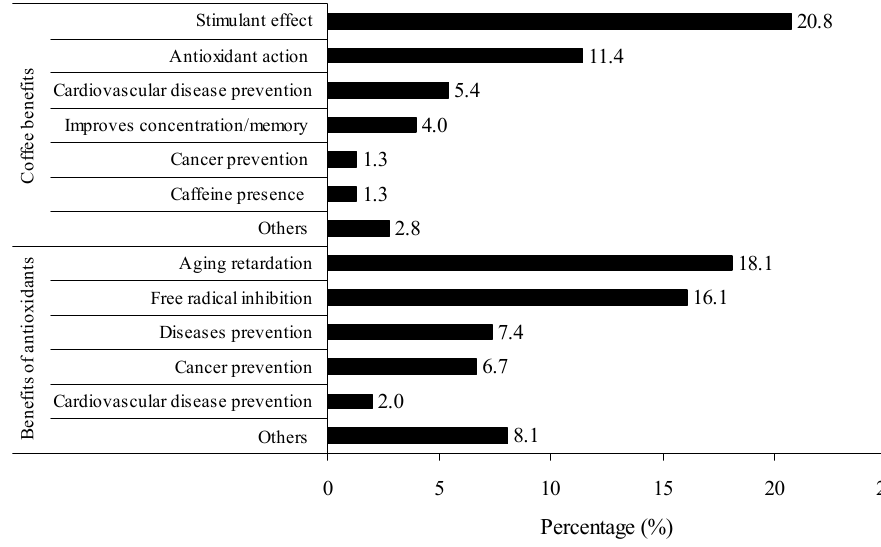
Figure 3. Consumer knowledge regarding to the benefits of the intake of antioxidants and coffee ( n =